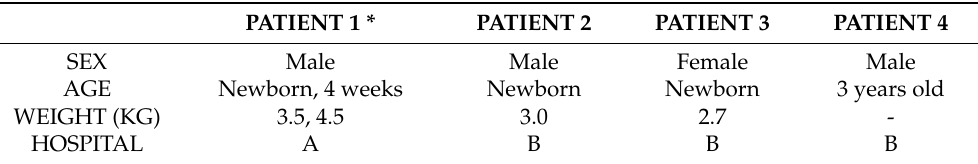
Table 1. Patient Demographics.